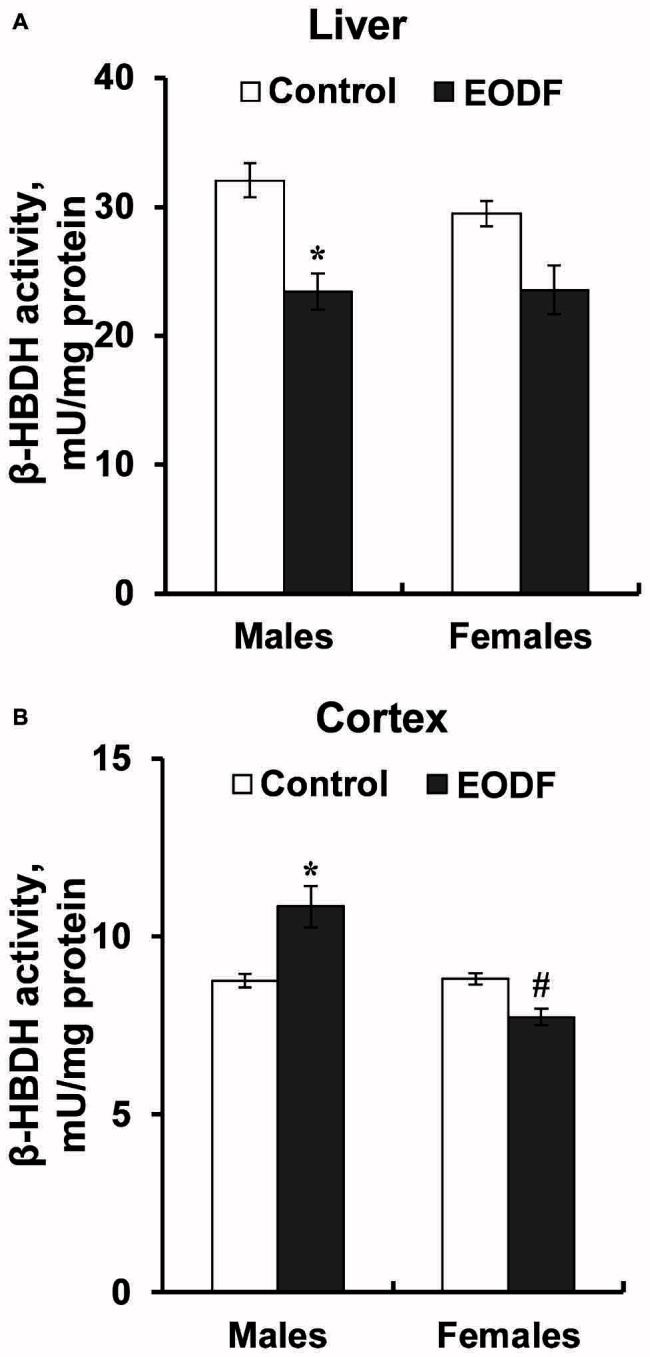
The activity of β-hydroxybutyrate dehydrogenase (HBDH) in the liver (A) and the cortex (B) of mice fed ad libitum (control) or subjected to an every-other-day feeding regimen (EODF) over 1 month, n = 5–6 mice. *Significantly different from the control group (p < 0.05), #significantly different from corresponding group of males (p < 0.05) by Welch’s t test with Benjamini-Hochberg adjustment of p.